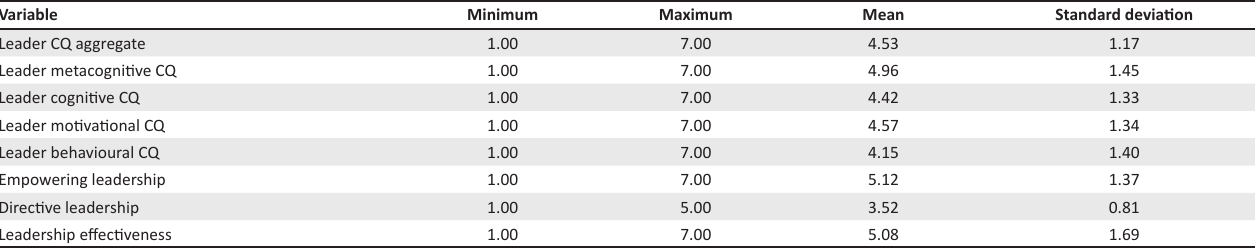
TABLE 4: Descriptive